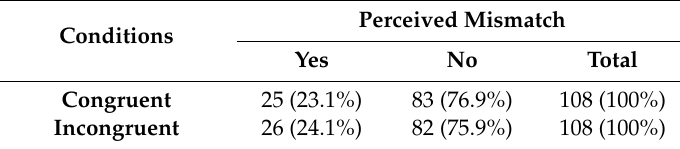
Table 9. Count and proportions (%) of perceived mismatch amongst (in)congruent conditions.